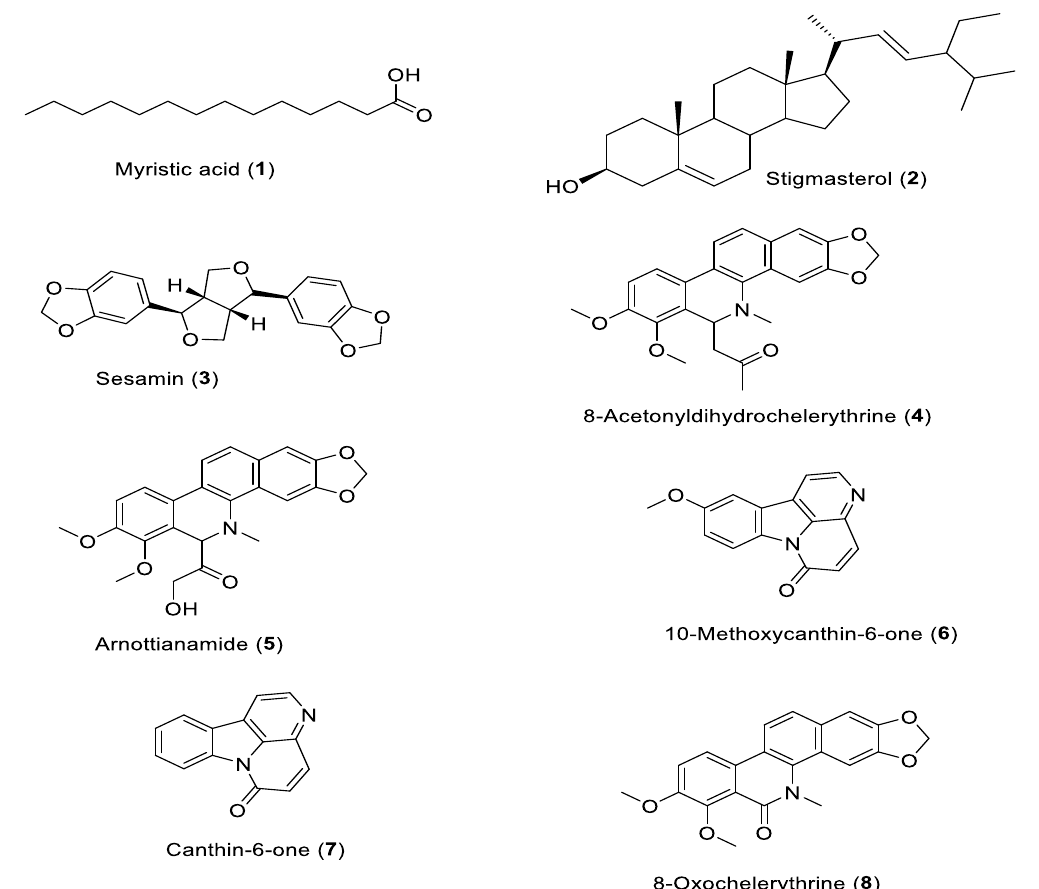
Table 1. Antimicrobial minimal inhibition concentration (MIC) values (µg/mL) of the tested samples .